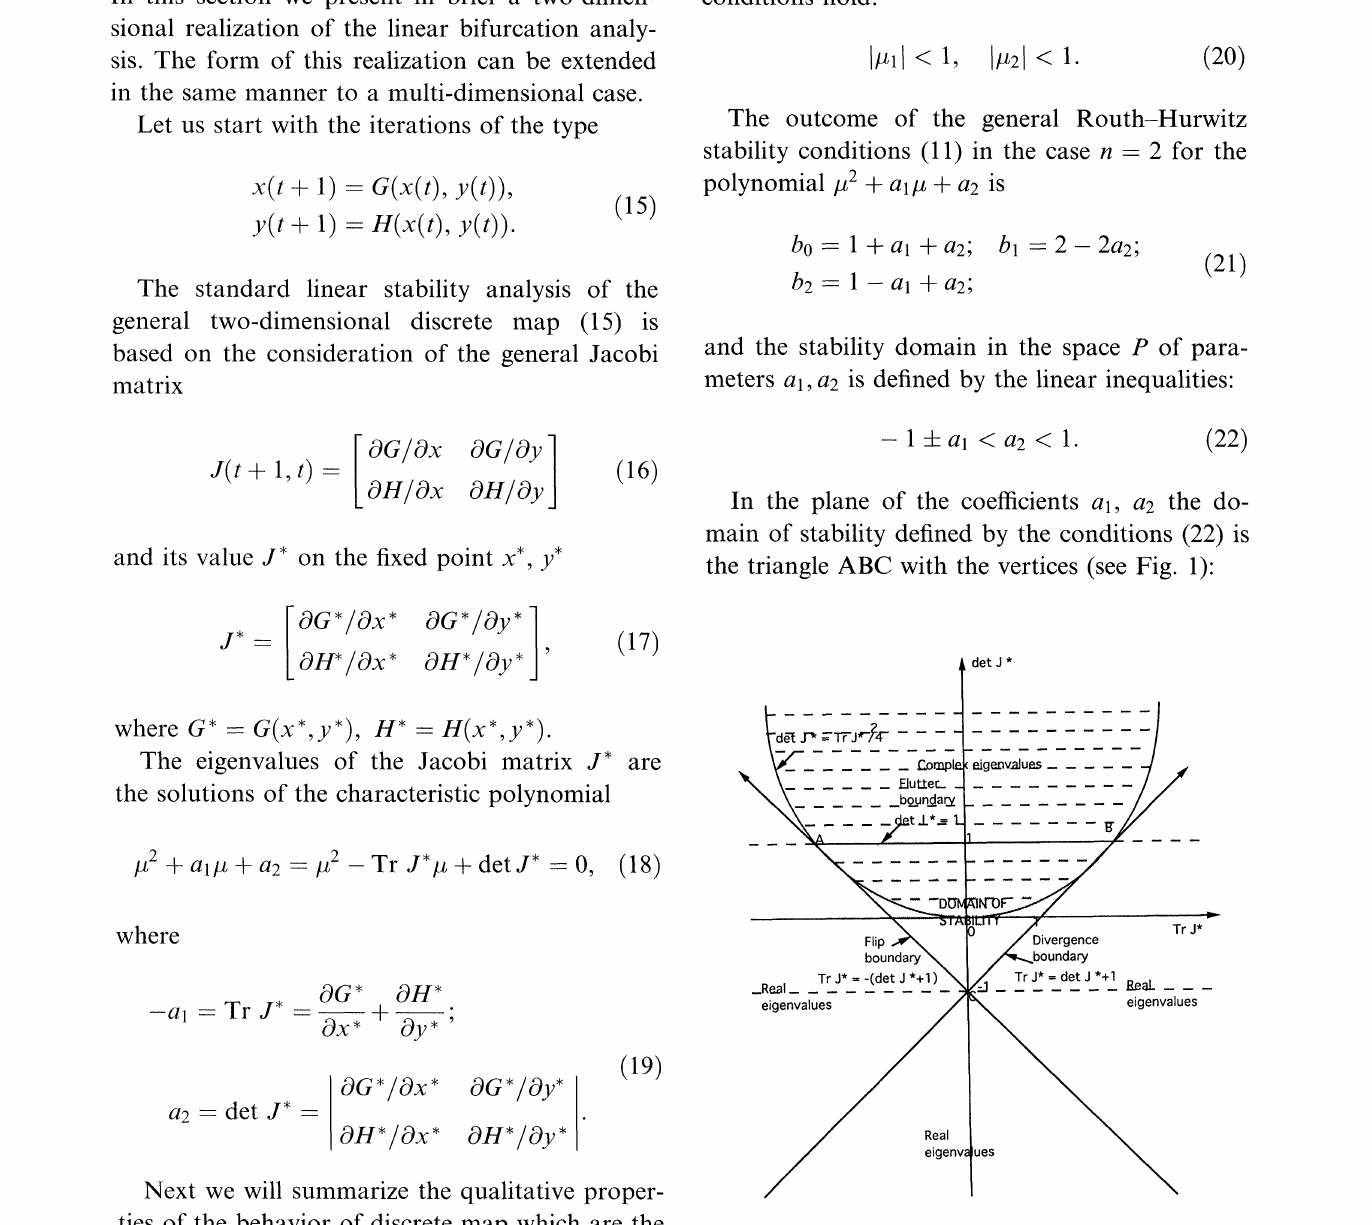
Domain of stability of discrete two-dimensional non-linear